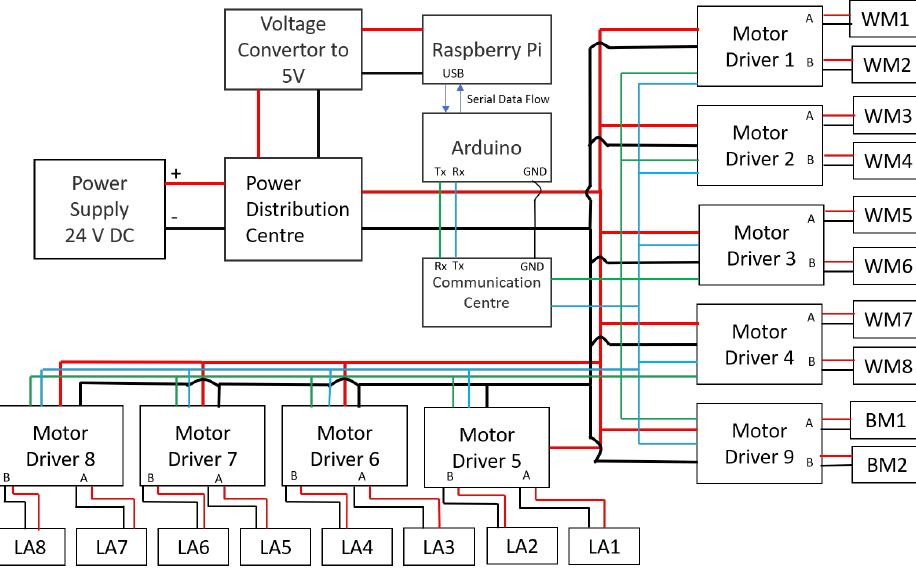
Figure 4. System architecture of the platform.